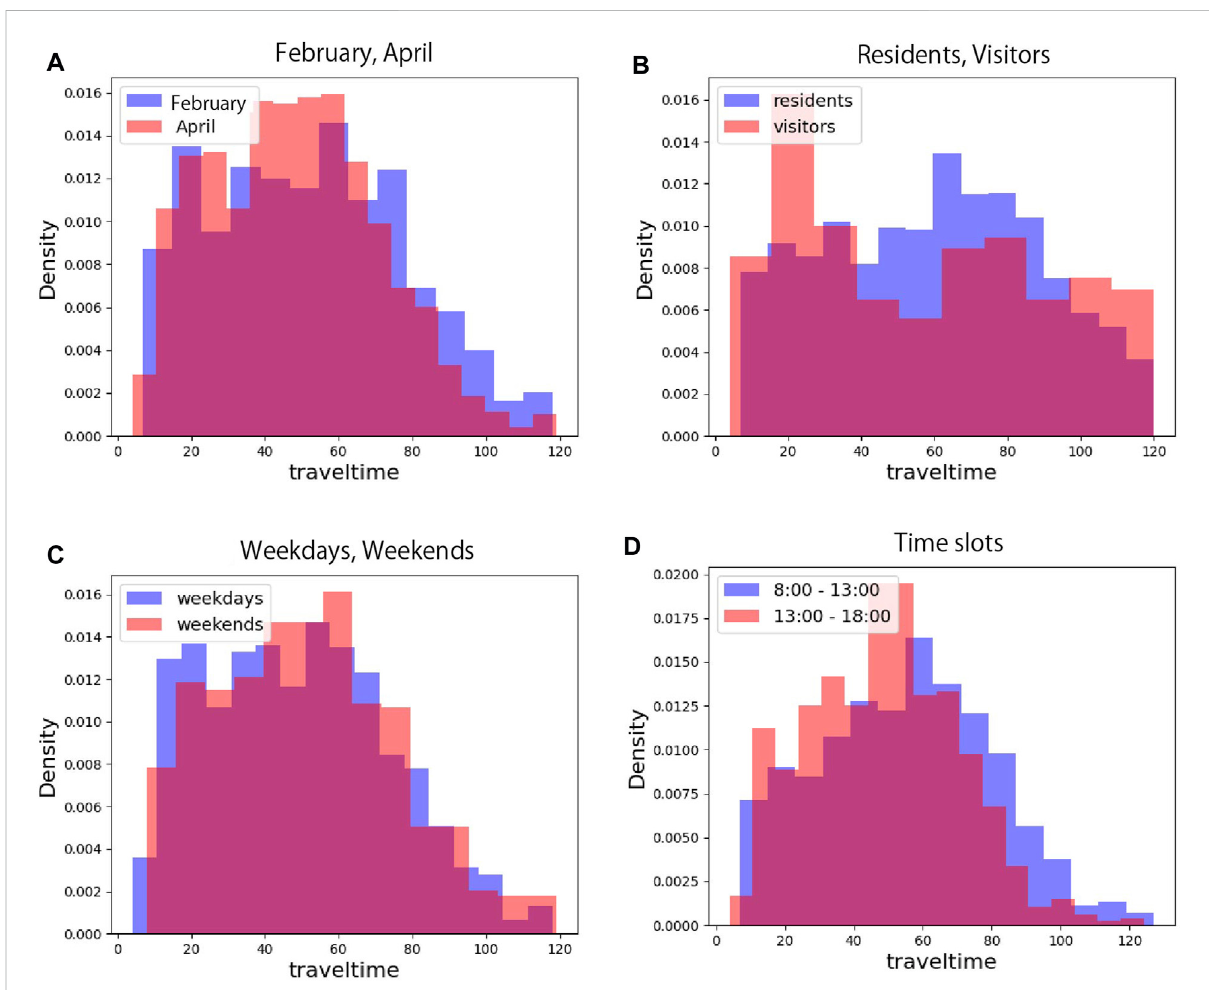
FIGURE 7 A density function is formed for the travel time from Ennmachi intersection to Kyoto Station by classifying sets of optimal paths for each condition.Theconditionsin (A – D) arethesameasinFigure6.Thetraf fi ccharacteristicsdescribedinthesectionareclari fi edbycomparingthis fi gure with Figure